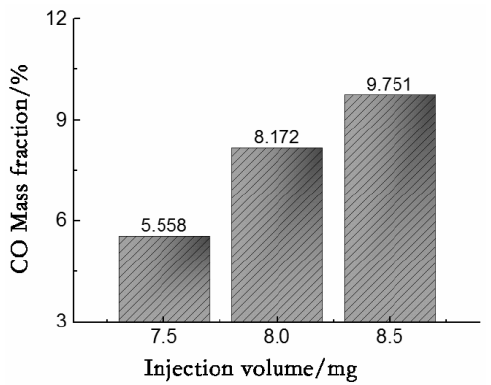
Figure 29. CO data corresponding to different injection volumes.